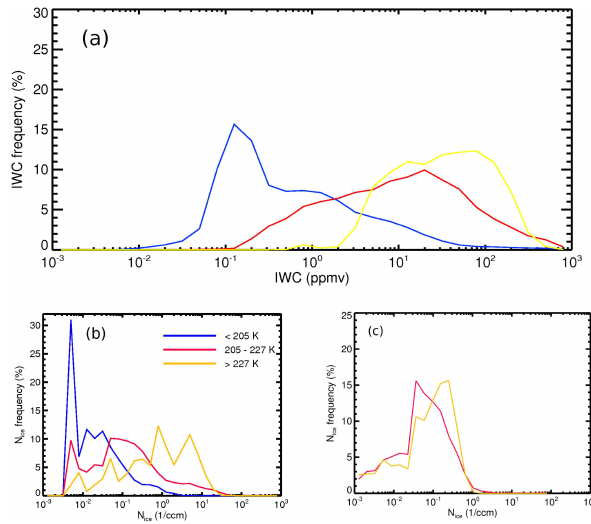
ber (FSSP); (c) Bottom-right: PDF of crystal number (CAPS). (b) is reproduced from Fig. 7a of Salzmann et al.